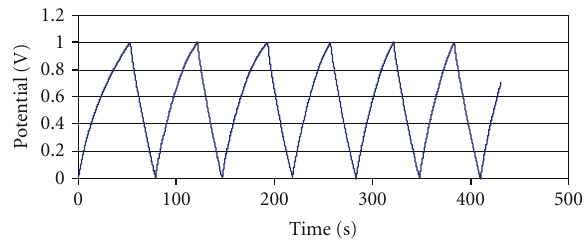
Figure 7: Charge-discharge testing of EDLC CNT-GF/F capacitor at constant current steps of − 20 μ A and +20 μ A; each carbon electrode has an area of 1 cm 2 and mass of 0.2mg.